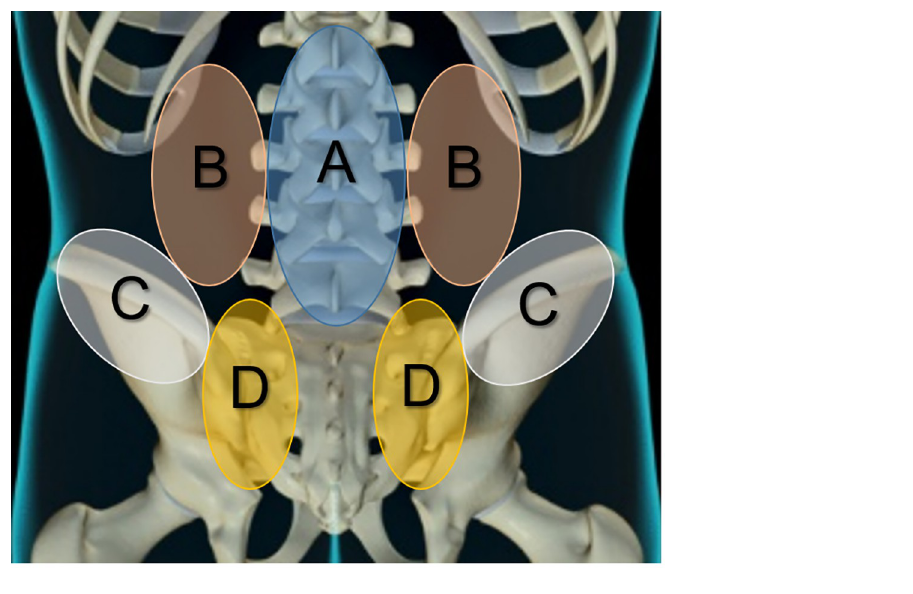
Fig 1. Localization diagnosis of low back pain. The location of low back pain (LBP) was categorized into four areas by palpation: A. midline of the lumbar region; B. paravertebral muscles; C. upper buttock; and D. sacroiliac joint.